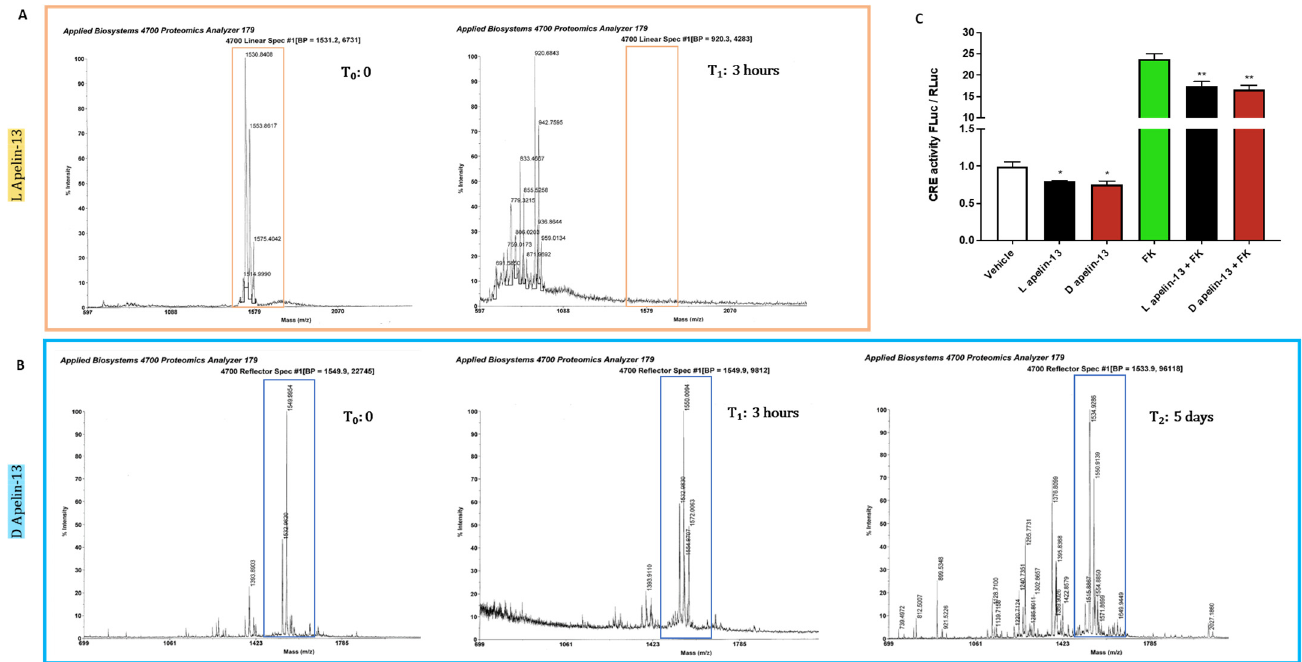
Figure 4. While L-apelin 13 is degraded in mouse serum in three hours, D-apelin 13 is stable for days. The peptide [Pyr1]-apelin 13 (MW 1533.81 g/mol) in L version ( A ) or D version of apelin 13 ( B ) were incubated at the same concentration in mouse serum at 37 °C. After different times from three hours to five days, a sample was analyzed using a MALDI-TOF mass spectrometer in linear mode. The molecular weights were compared with the original peptides at time 0. The highlighted peak that detects L-apelin 13 disappeared after 3 h ( A ), when additional peaks corresponding to lower molecular weights appear, indicating its fragmentation. Instead, D-apelin 13 was more stable in the mouse serum, because its peak (MW 1550 g/mol) persisted for five days ( B ). Myoblasts were transfected with a plasmid in which Firefly luciferase (FLuc) is under the control of cAMP responsive elements (CRE) and another for Renilla luciferase (RLuc) under the control of thymidine kinase pro- moter, to normalize the data. After 24 h, myoblasts were treated for 5 h with vehicle or 1 μ M L- apelin 13 or D-apelin 13, in combination with vehicle or 50 μ M forskolin and the ratio of FLuc/RLuc is plotted. L-apelin 13 and D-apelin 13 were equally able to reduce cAMP and forskolin-induced cAMP by about 25% in luciferase assays ( C ). Ordinary one-way ANOVA, * p ≤ 0.05, ** p ≤ 0.01, n = 6. 3.4. Preproapelin or Apelin Given to Cancer-Bearing Mice Does Not Affect Muscle Size at All To select the cachectic cell line more resistant to apelin for in vivo experiments, we treated the cancer cell lines able to cause cachexia (C26, LLC, MCG101) with these long- lived apelin peptides at increasing doses and times. Only supraphysiological doses of D- apelin 13 (250 μ M at 24 h and 100 and 250 μ M at 48 h) reduced the viability of most cancer cells (Supplementary Figure S9A–D). We injected 3 × 10 10 units of preproapelin-expressing AAV9 in the TA of mice previ- ously injected with PBS or C26, and weighed muscles at sacrifice. There was no preserva- tion of TA weight (Figure 5A); although apelin was properly overexpressed (Figure 5B), its inductions was able to restrain neither MuRF1 expression (Figure 5C) nor that of atrogin-1 (Supplementary Figure S10), as it did in vitro (Figure 3G). After having tested that D-apelin 13 has similar in vitro effects as L-apelin 13, we also injected D-apelin 13 in C26-bearing mice at doses and times that had previously assumed were not toxic in vivo. There was no body or MWL in tumor-free mice injected intraperitoneally (i.p.) with D- apelin 13 up to 1.5 μ mol/Kg daily for 13 days (Figure 5D and data not shown). Again, apelin did not appear to have any effect on body or MWL (Figure 5E–H) or on tumor growth (Figure 5I), confirming that regardless of the route of administration, activation of this pathway does not preserve muscle size.